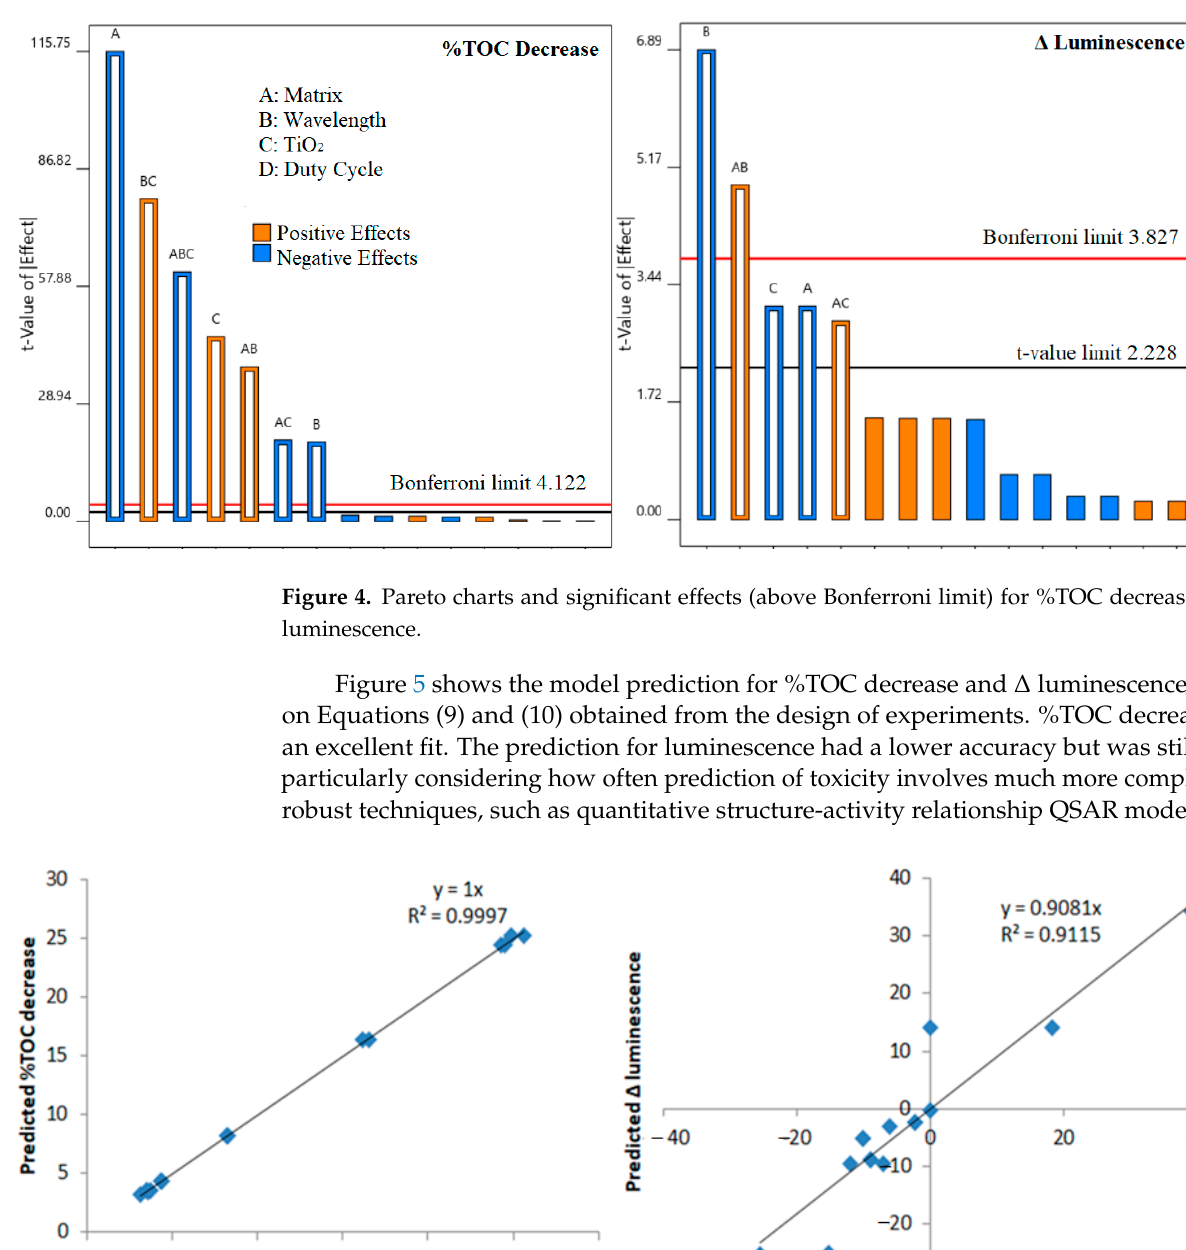
Figure 4. Pareto charts and significant effects (above Bonferroni limit) for %TOC decrease and Δ luminescence.